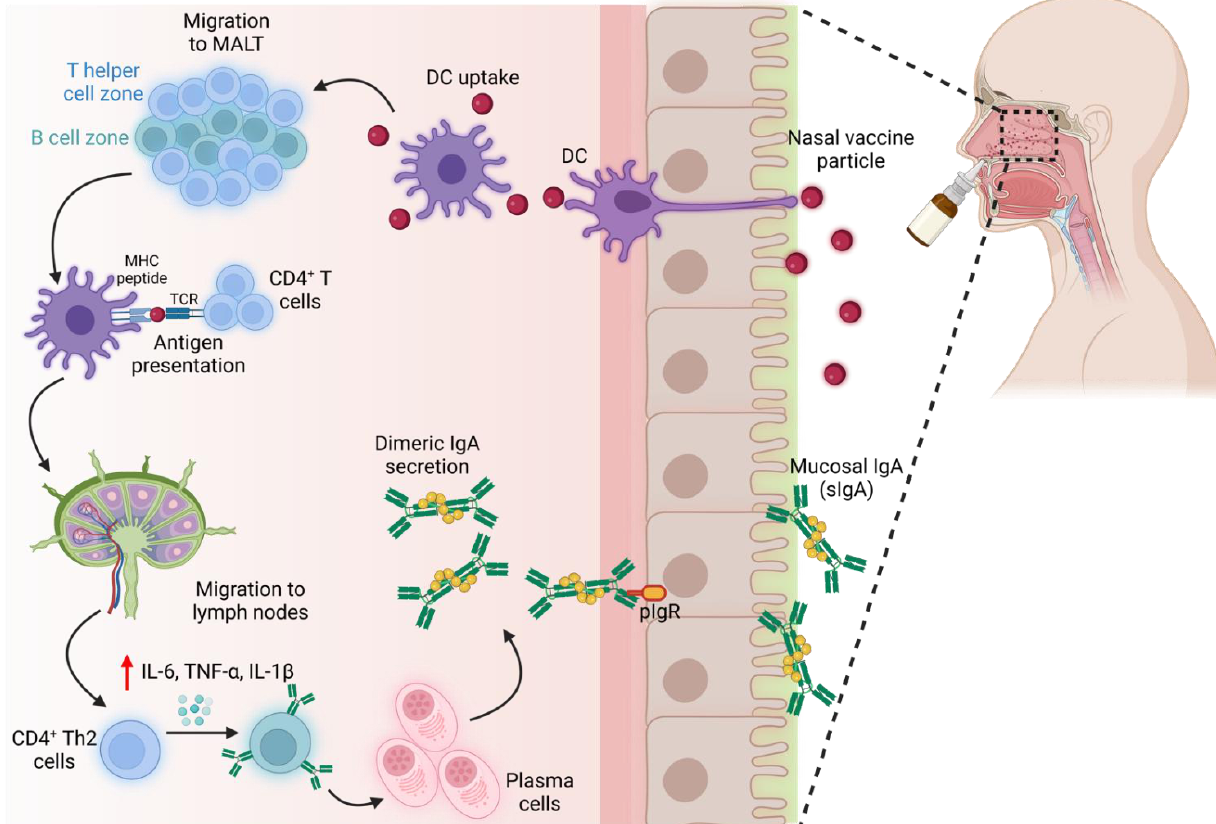
Figure 3. Induction of neutralizing IgA with intranasal vaccines. An immune response is elicited in MALT, leading to the secretion of IgA on the mucosal surface. (MALT—mucosa-associated lymphoid tissue). Protein subunit vaccines are less immunogenic and necessitate the incorporation of mu- Table 1. Intranasal vaccine adjuvants of IgA production against respiratory pathogens. cosal adjuvants. The rapid enzymatic degradation of protein subunits also urges the need for a delivery platform. Recently, a group of researchers engineered a nanoemulsion-based mucosal adjuvant that encapsulated RNA agonist, RIG-I, in tandem with recombinant SARS-CoV-2 protein vaccine. This agonist activates TLRs and NLRP3 to enhance im- munogenicity and elicited superior Th-1-based cellular responses with elevated levels of neutralizing antibodies against SARS-CoV-2 and other mutant variants [68]. A series of cationic nanocarriers such as polyethyleneimine (PEI), chitosan, and